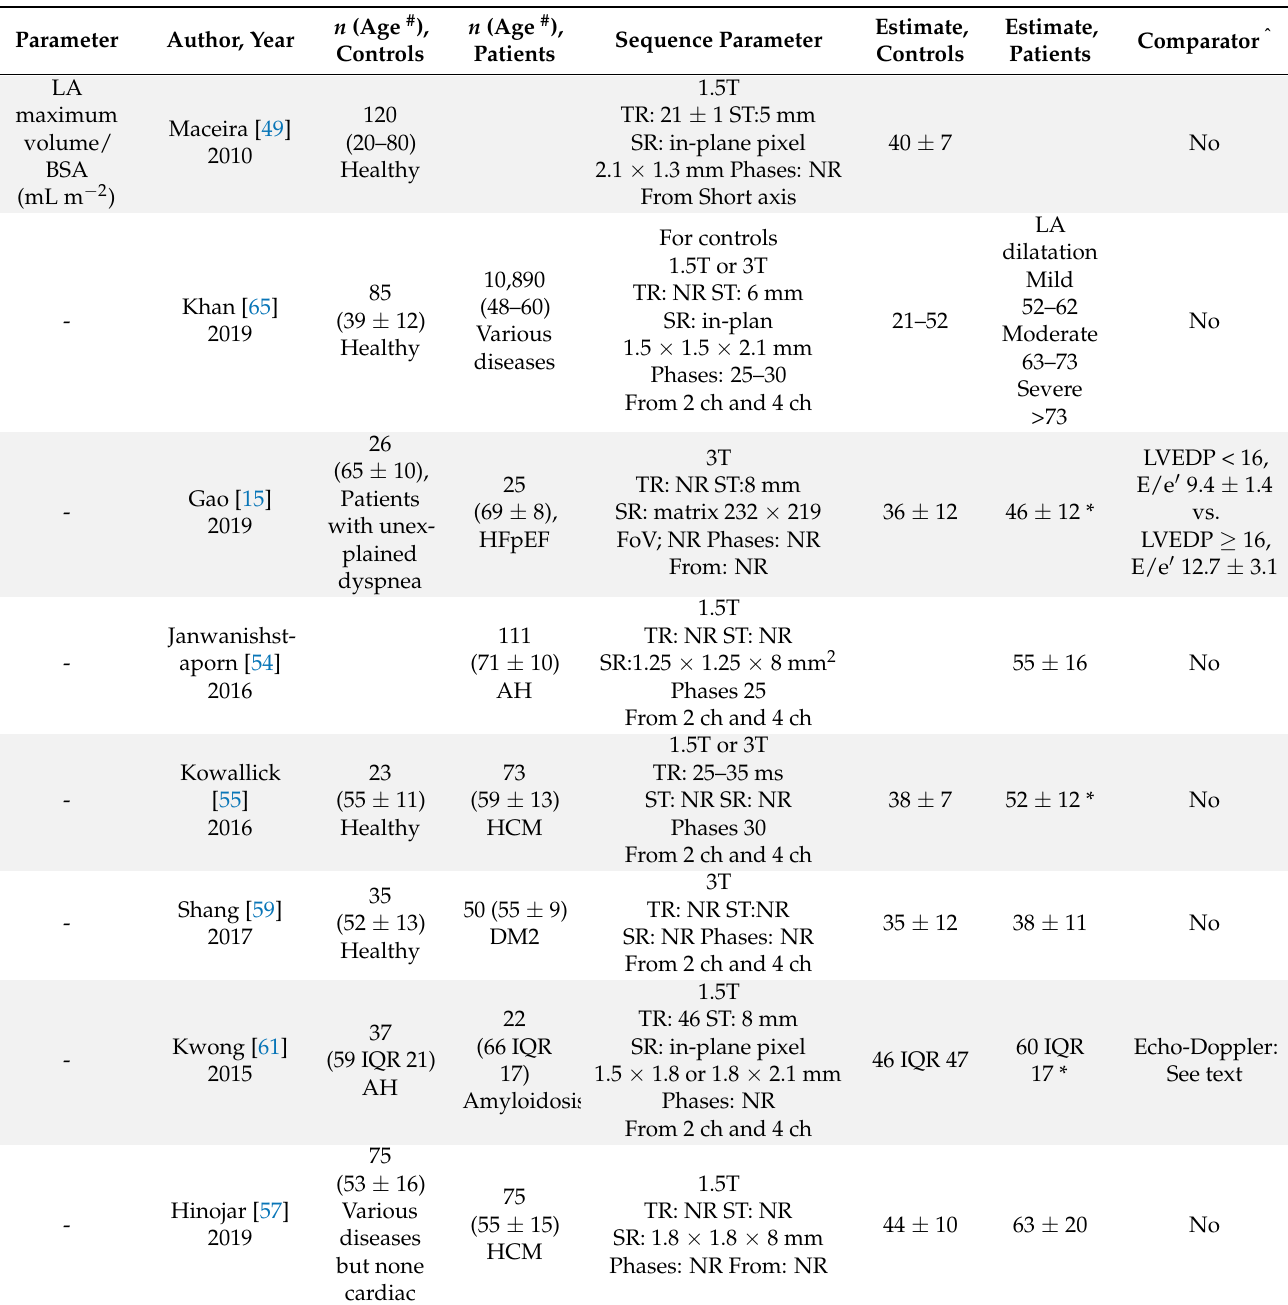
Table 8. LA time/volume curves—maximum LA volume.